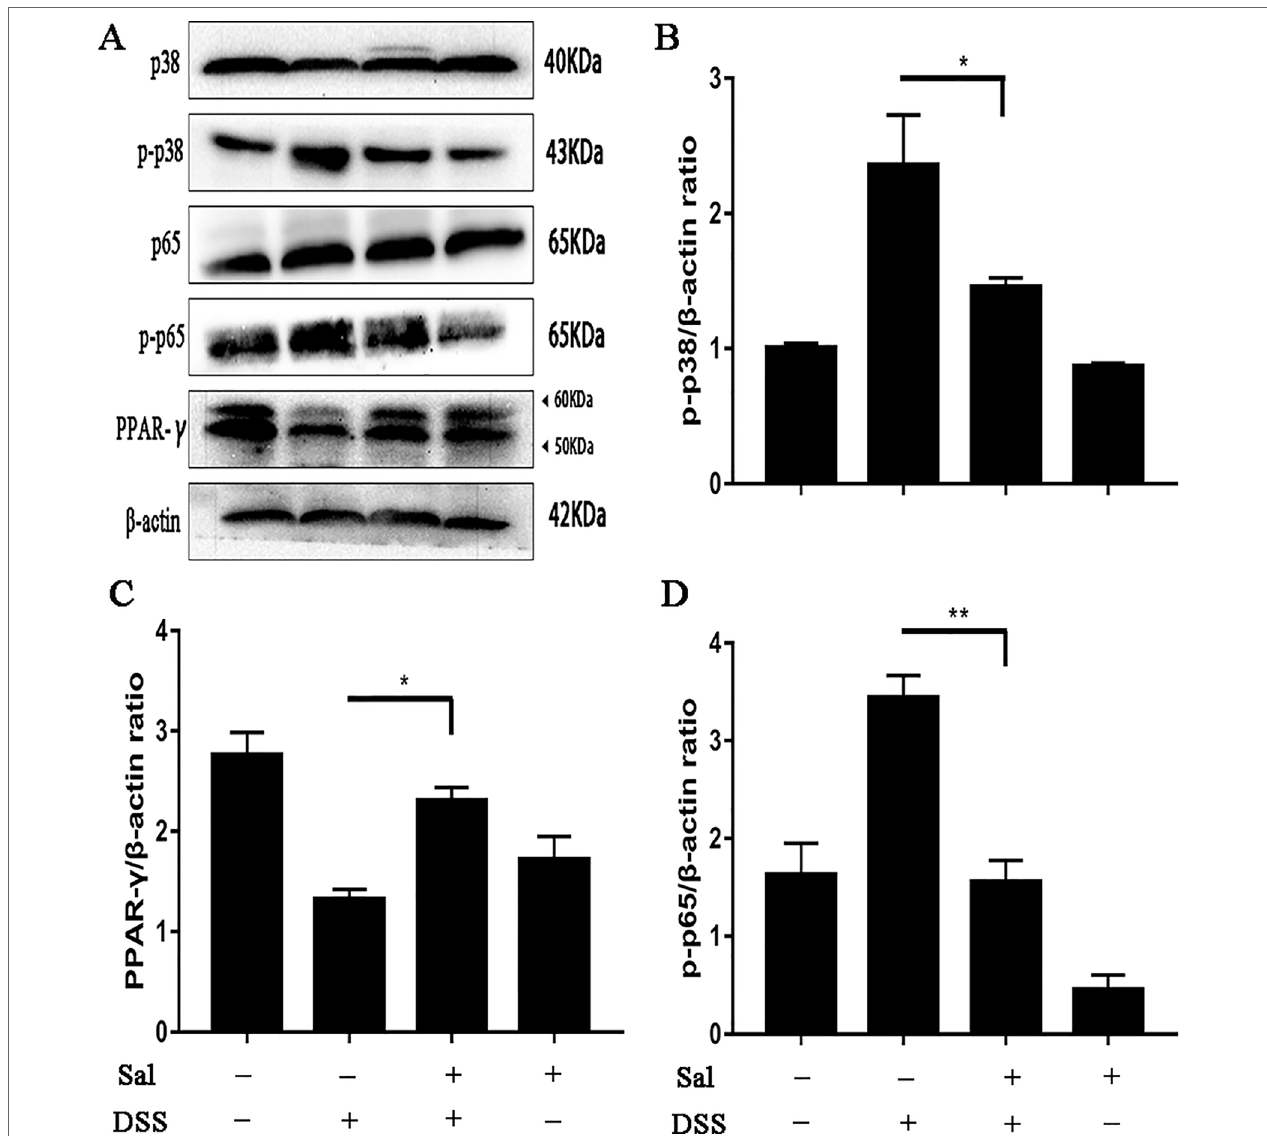
FIgURe 3 | Salidroside restrained the phosphorylation of p65 and p38 accompanied with recovering peroxisome proliferator-activated receptor (PPARγ) protein level in dextran sulfate sodium-treated mice. (A) P65, p38, and PPARγ protein levels in the colonic tissue were analyzed by western blot. (B, C, D) The relative protein expression of p65, p38, and PPARγ were normalized to β-actin. Data were repeated in three independent experiments. (*) p < 0.05, (**) p < 0.01.